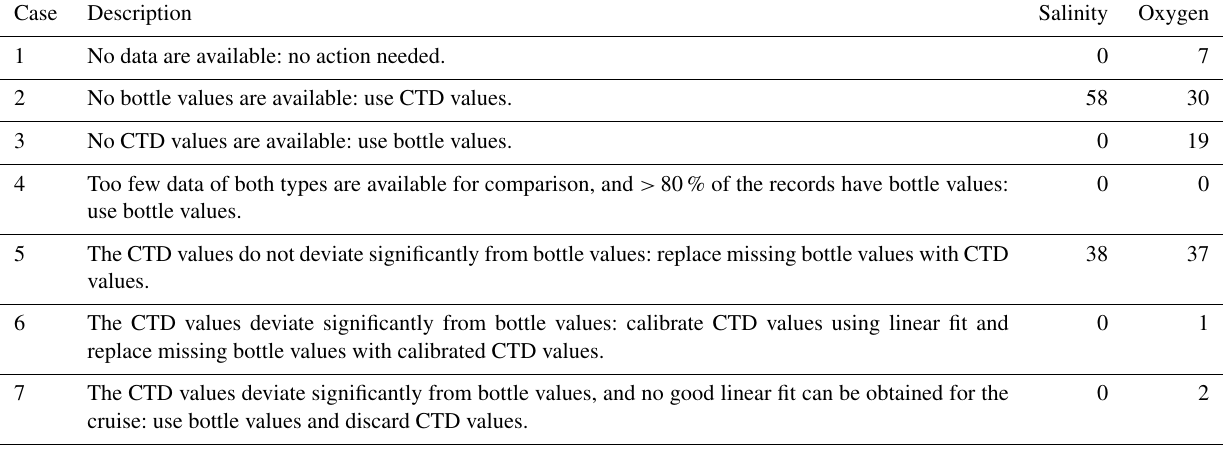
Table 4. Summary of salinity and oxygen calibration needs and actions; number of cruises with each of the scenarios identified.